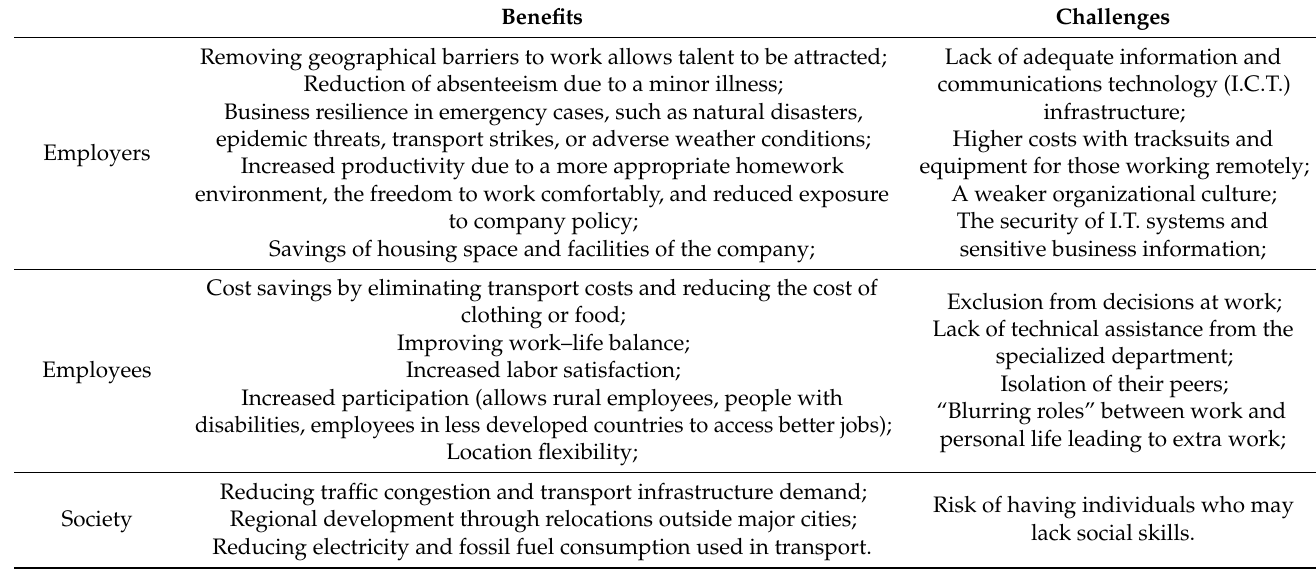
Table 1. Benefits and disadvantages of